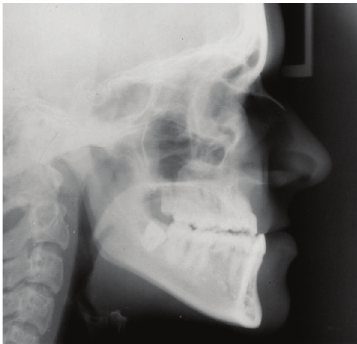
Figure 6: Lateral cephalogram of patient 3 showing a skeletal Class III relationship.